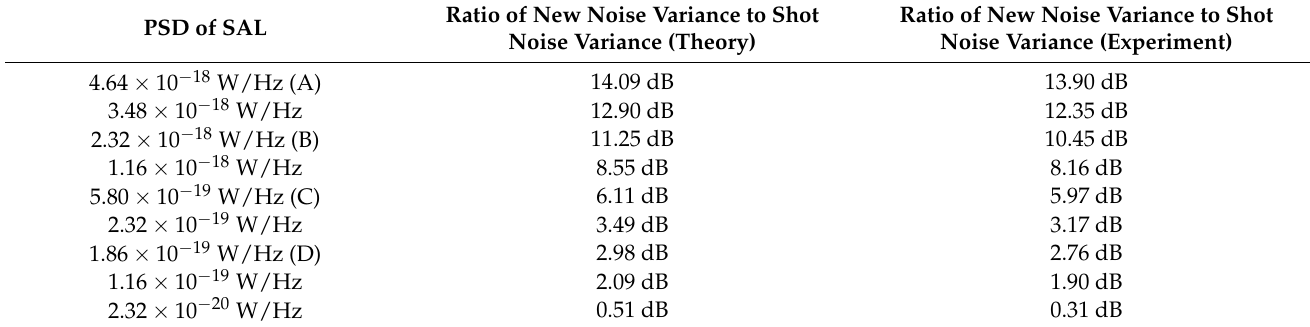
Table 3. PSD of SAL, ratio of new noise variance to shot noise variance (theory and experiment).